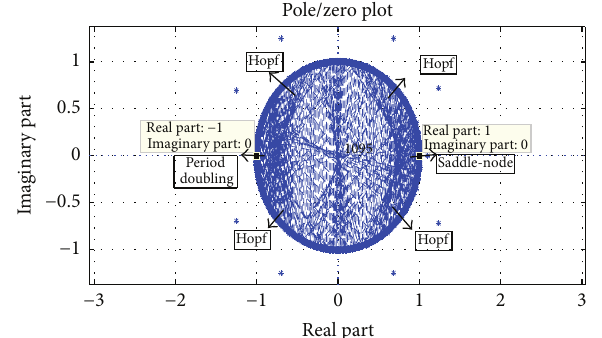
Figure 8: Three modes of bifurcations defined by Floquet multipli- ers through the unit circle on the complex